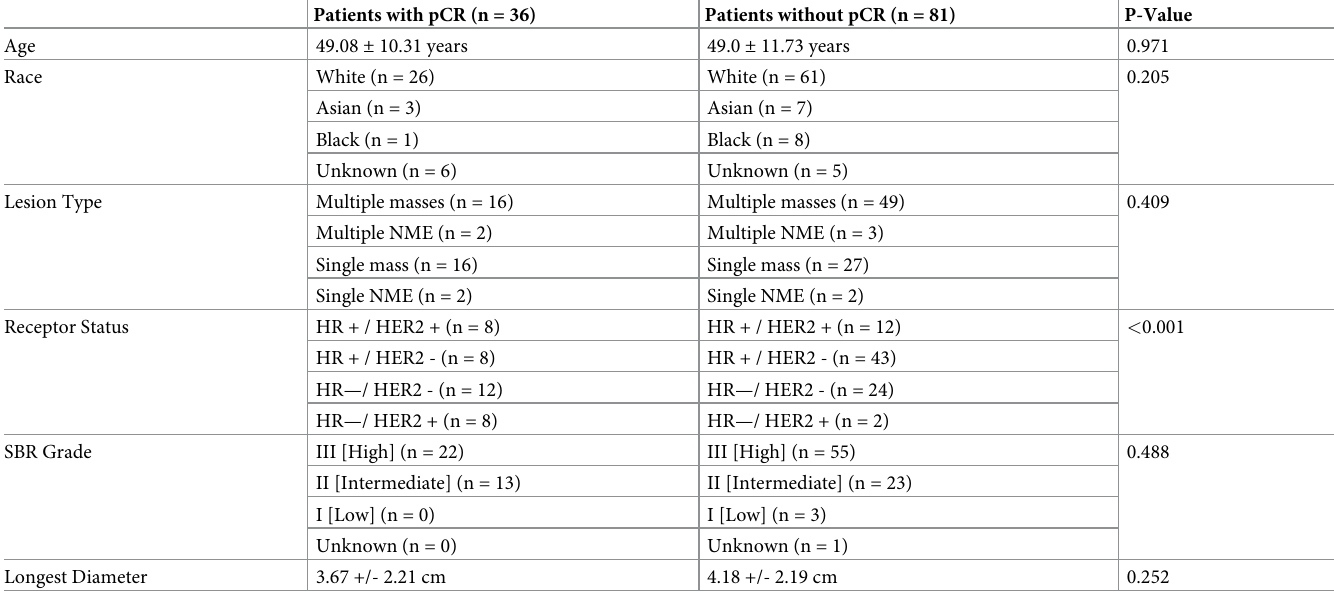
Table 2. Patient demographics and sample